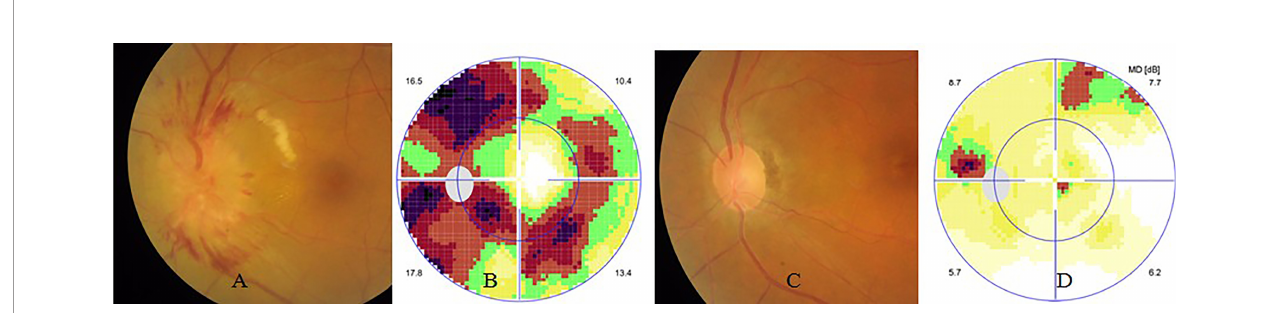
FIGURE 4 | Syphilic optic neuritis. The left eye of the same case in Figure 2 . At presentation, his left eye had visual acuity of 20/20, clear anterior segment and swollen optic disc (A) , and circular scotoma on visual fi eld test (B) .Two months after antibiotic therapy, his visual acuity was still 20/20, with normal optic disc (C) , and nearly normal visual fi eld test (D)